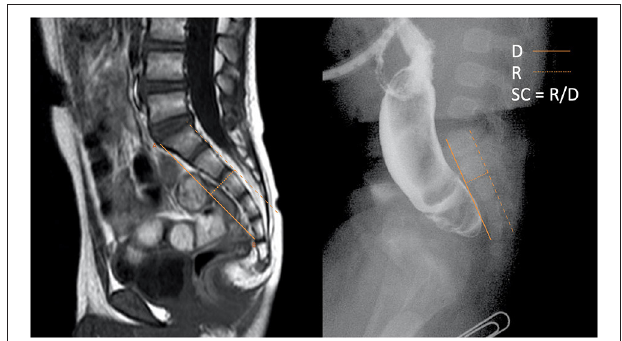
FIGURE 2 | SC measurement in MRI and x-ray.